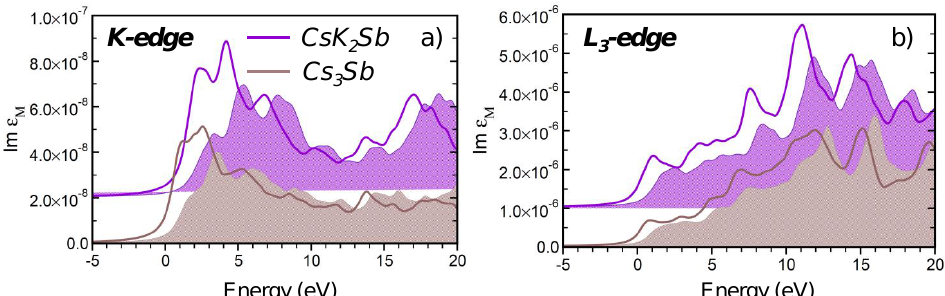
Figure 6. X-ray absorption spectra from ( a ) the Sb K -edge and ( b ) the Sb L 3 -edge of Cs 3 Sb and CsK 2 Sb, calculated by including and neglecting excitonic effects by solving the full BSE (solid lines) or in the IQPA (shaded areas), respectively. The edge of the IQPA spectra is set to 0 eV, and the BSE results are aligned to it accordingly. A Lorentzian broadening of 500 meV is applied to all spectra to mimic the excitation